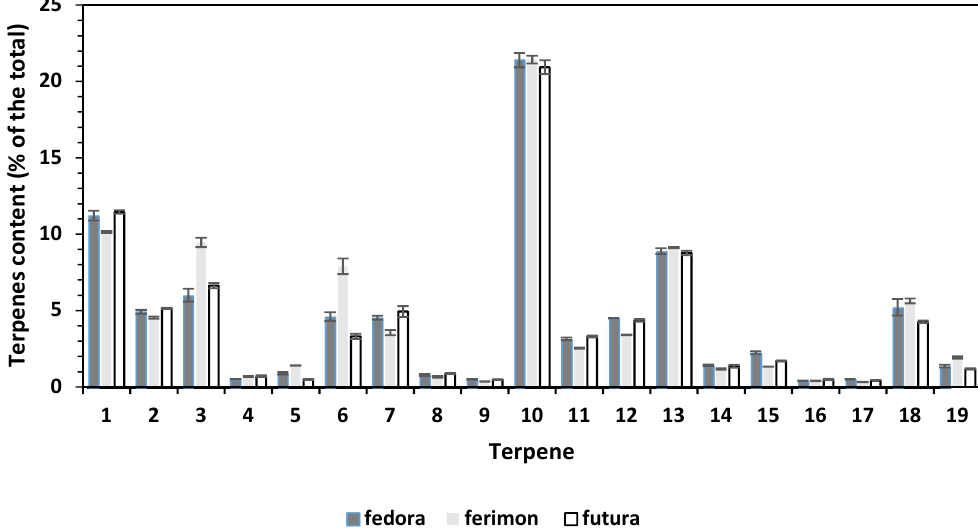
Figure 5. Relative percentage composition of the main and common constituents of EOs of the three varieties studied, as mean within the environments (1: α -Pinene; 2: β -Pinene; 3: β -Myrcene; 4: Eucalyptol 1,8 Cineol; 5: trans- β -Ocimene; 6: β -Ocimene; 7: Terpinolene; 8: Isocaryophyllene; 9: cis- α -Bergamotene; 10: Caryophyllene; 11: trans- α -Bergamotene; 12: cis- β -Farnesene; 13: Humulene; 14: Aromandendrene; 15: α -Selinene; 16: Selina-3,7(11)-diene; 17: β -Sesquiphellandrene; 18: Caryophyllene oxide; 19: Humulene epoxide II). Bars represent standard